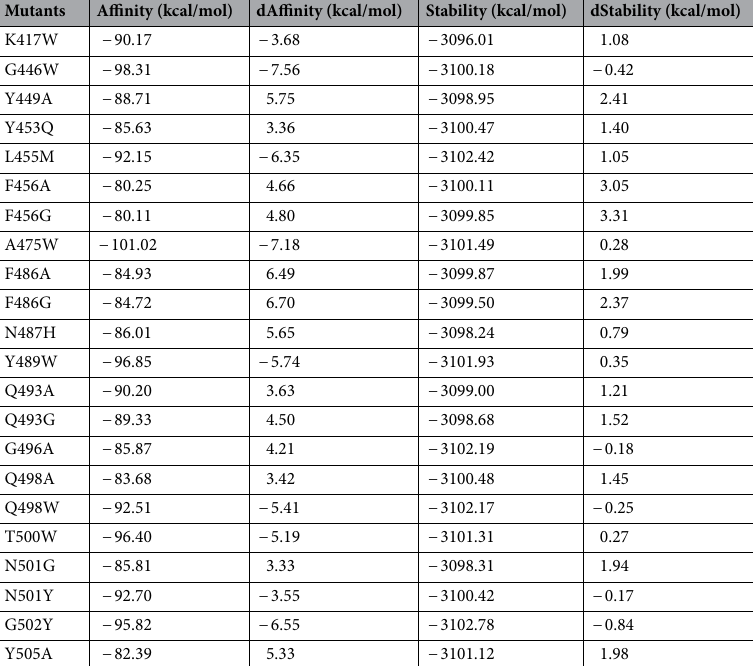
Table 1. The affinity and stability of different variants of spike protein RBD bound to